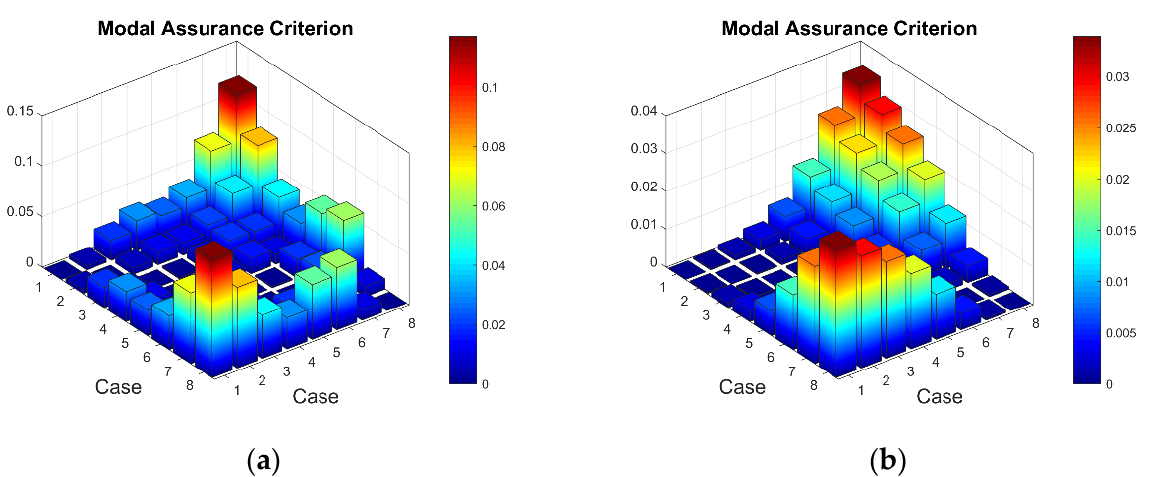
Figure 19. The MAC values comparing strain mode shapes for different location of delamination damage: ( a ) first resonant frequency, ( b ) seventh resonant frequency.